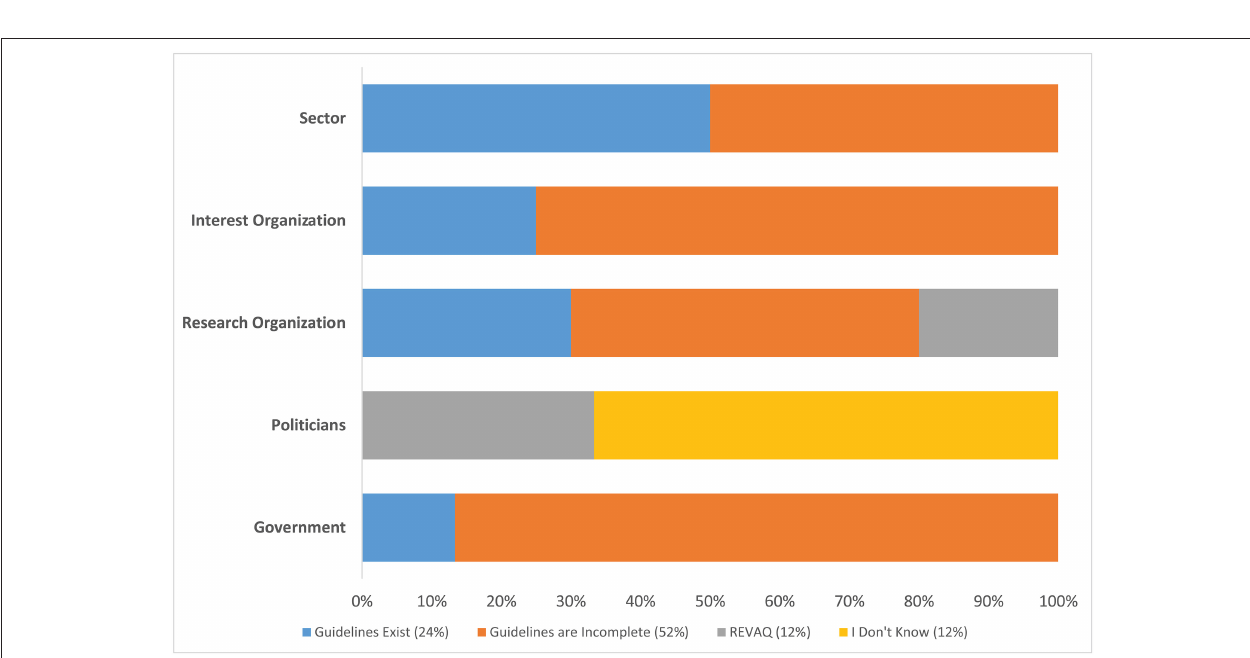
FIGURE 8 | “What are the current guidelines for pollutants in sludge?” Percentages reported represent the frequency with which an issue was mentioned across all stakeholders responding ( n = 33).